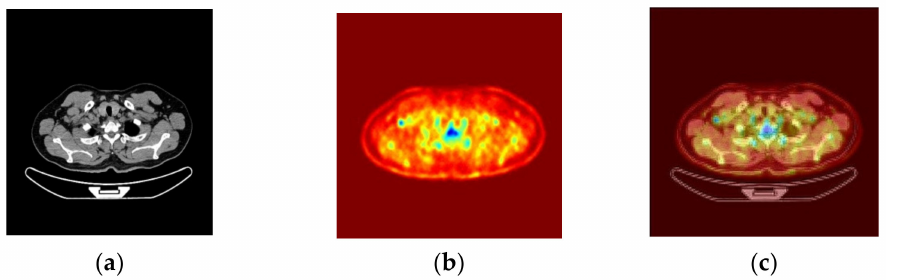
Figure 9. Fusion of PET and CT. ( a ) CT image. ( b ) PET pseudo-color image with 256 colors. ( c ) The PET image is fused with the CT image.